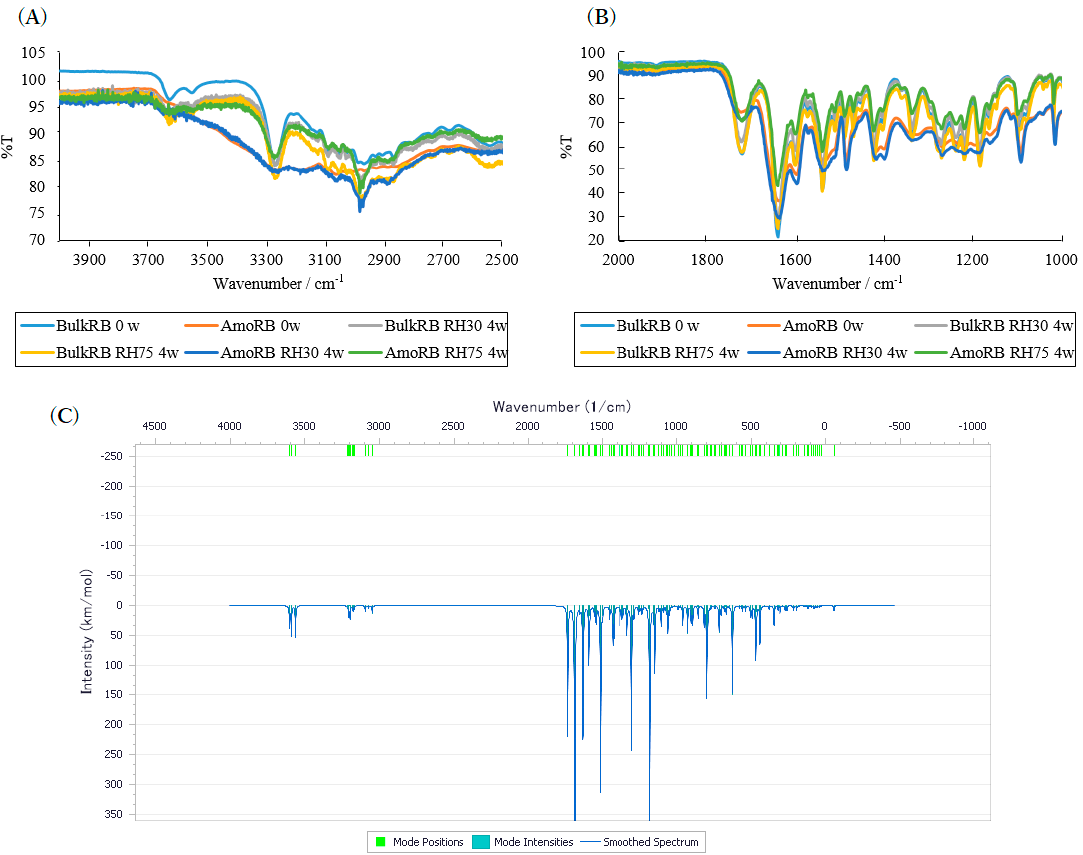
Figure 3. Attenuated total reflection-mid-infrared spectra of RB form I, ground RB and stored samples. RB form I sample stored for 4 weeks in RH 30% and RH 75%. The two regions of 4000 to 2500 cm − 1 ( A ) and 2000 to 1000 cm − 1 ( B ). Simulated IR spectra of RB molecule based on ab initio calculation ( C ). RH; relative humidity. RB; rebamipide.